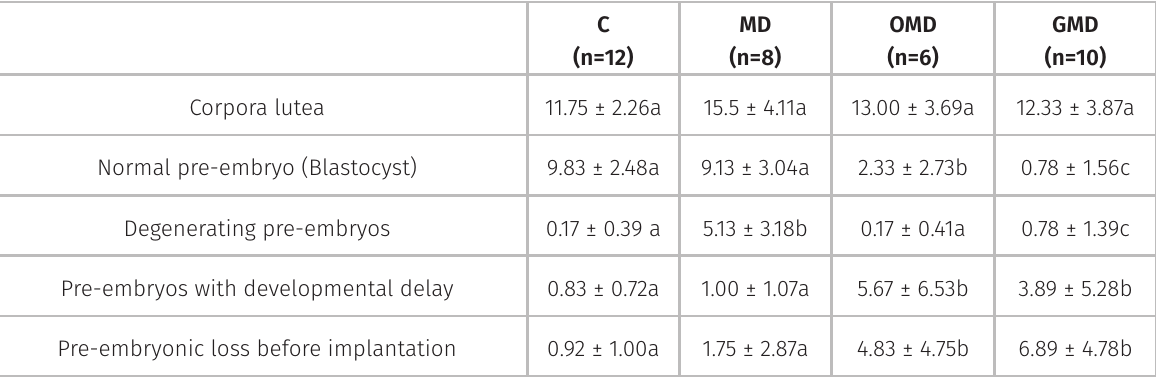
Table I. Pre-embryo (blastocyst) analysis on gestational day 4 of control (C) and mildly diabetic (MD) dams; and offspring (OMD) and granddaughters (GMD) exposed to transgenerational diabetes. Data reported as mean ± standard deviation. p<0.05 - different letters indicate significant statistically difference (Poisson Distribution followed by Wald’s Multiple Comparison